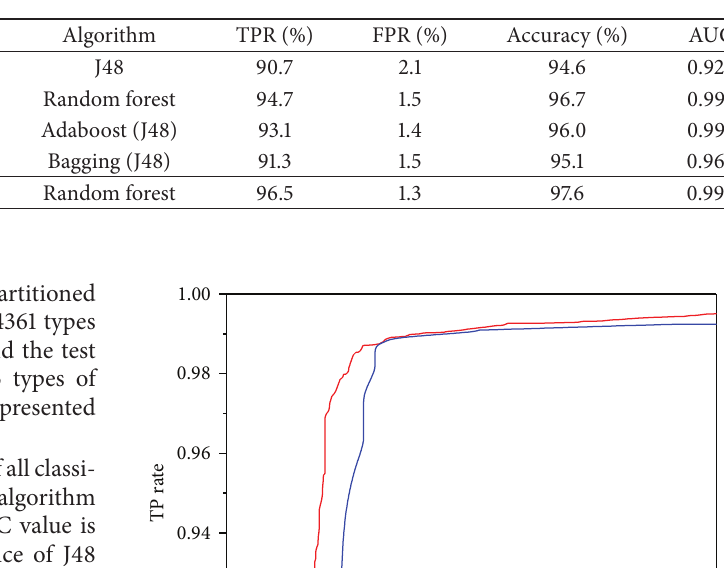
Table 6: Experimental results for all classification algorithms (the datasets are divided into the training set and the test set in chronological order).